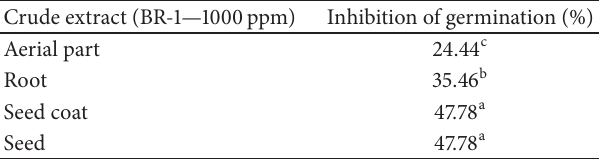
Table 1: Inhibition of L . sativa seeds germination by crude ethanolic extracts of aerial part, root, seed coat, and seed of BR-1 cultivar from Arachis hypogaea